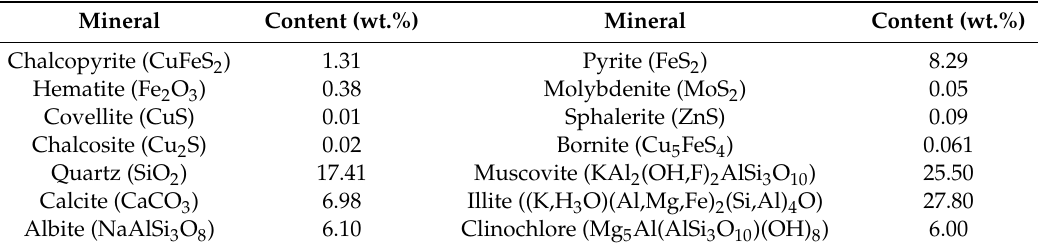
Table 2. Mineralogical composition (wt.%) of the studied